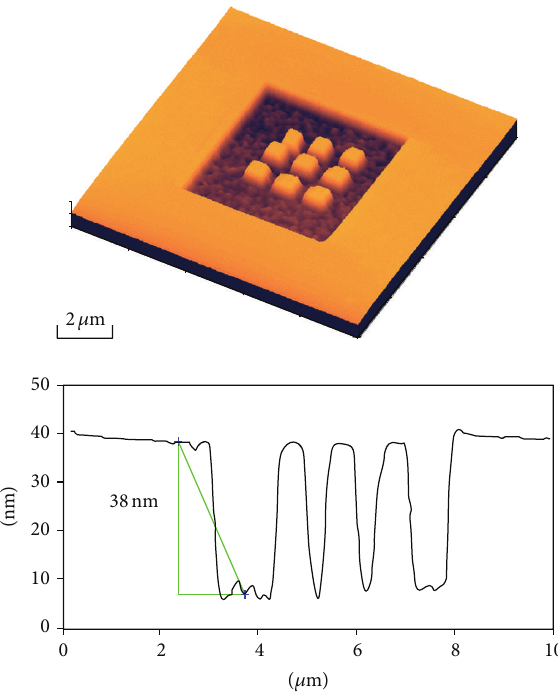
Figure 18: AFM profiles obtained using mechanochemically and naturally oxidized layers as etching masks for the KOH solution at 15 𝜇 N.